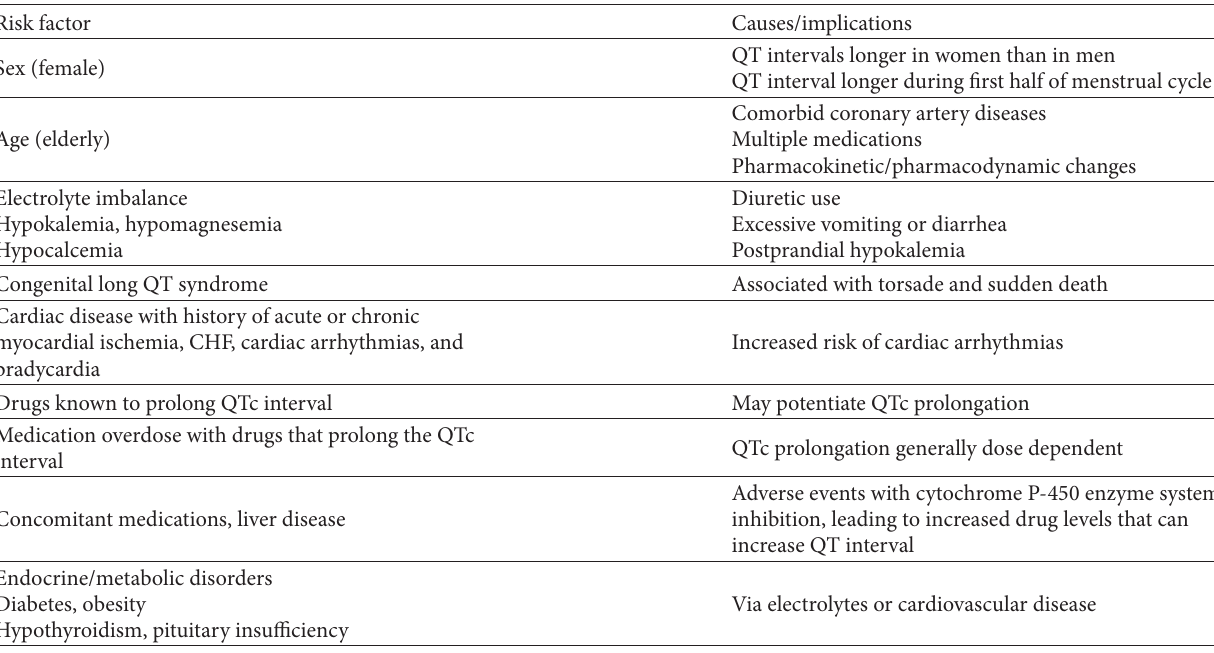
Table 4: Risk factors contributing to QTc interval prolongation and torsades de pointes.